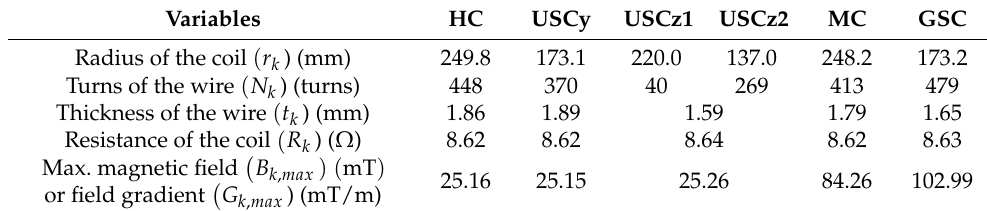
Table 1. Major variables of the optimized MNS.